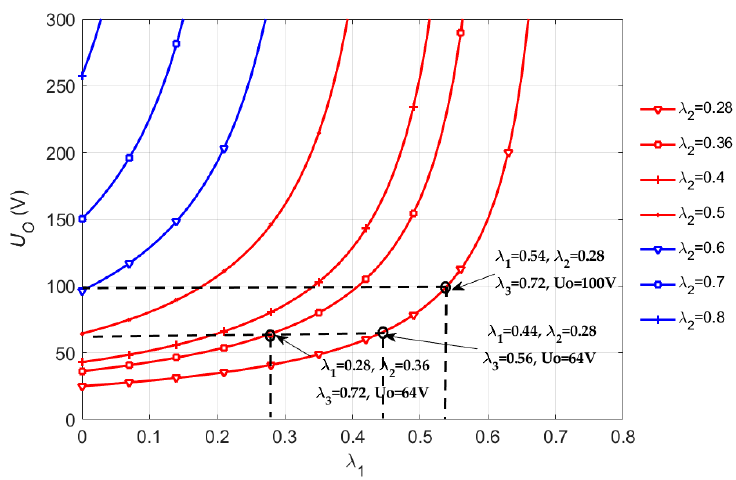
Figure 6. Relationship between of U O and λ 1 , λ 2 .